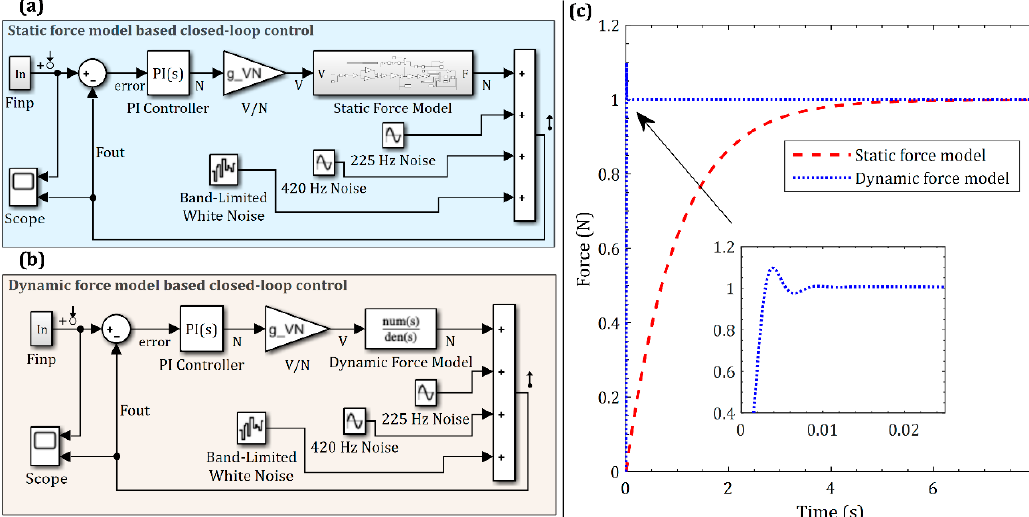
Figure 20. Model-based closed-loop control of the actuator; ( a ) Simulink model for static force model based closed-loop control; ( b ) Simulink model for dynamic force model based closed-loop control; ( c ) closed-loop step response of actuator using static and dynamic force models.